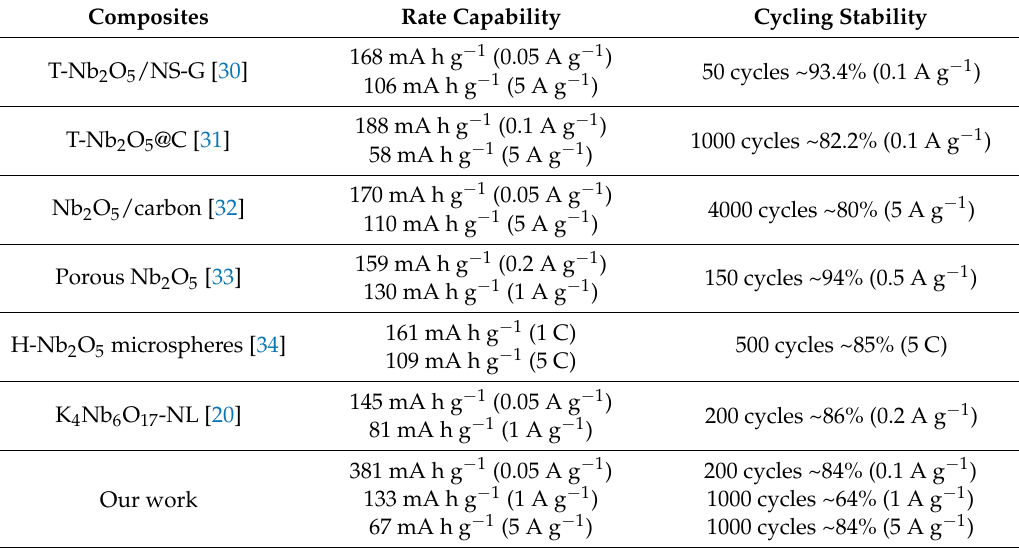
Table 1. A comparison study of performances between this work and the other related